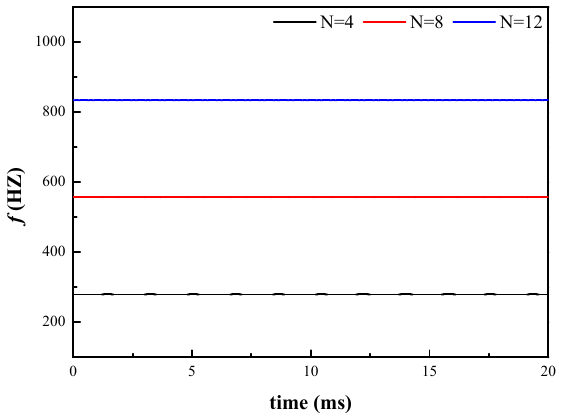
Figure 19. Accelerations of different orifice numbers.